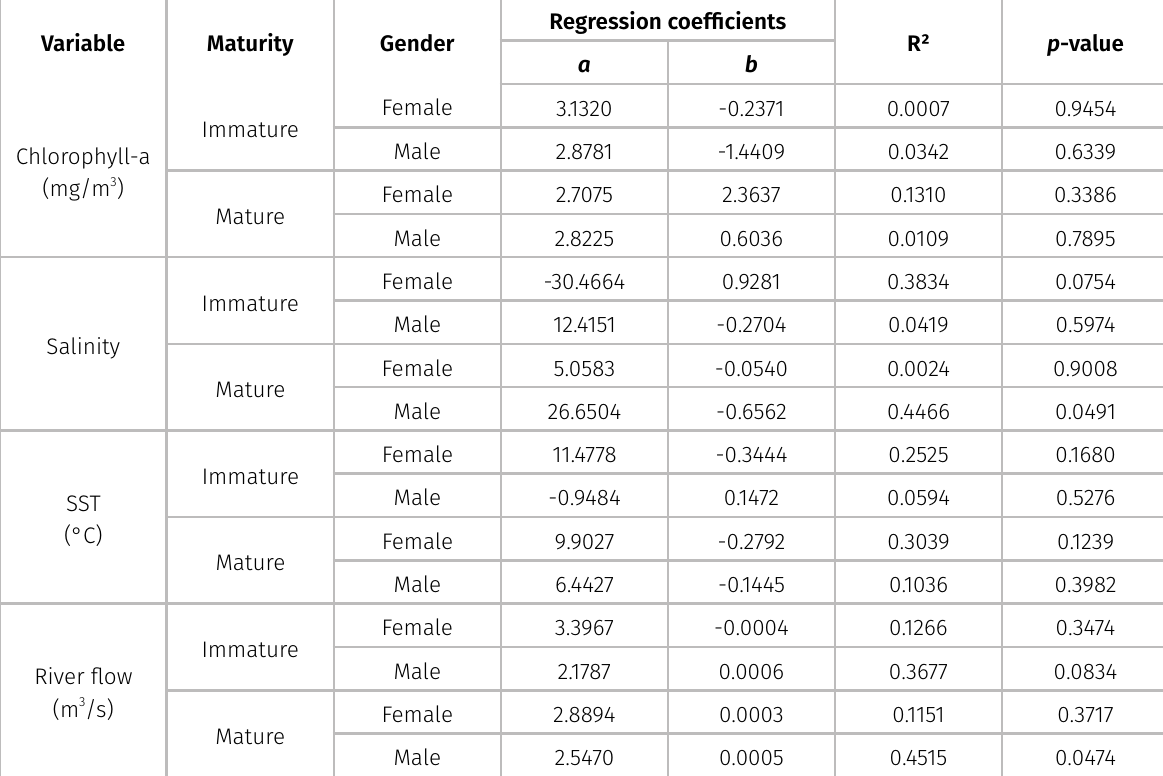
Table IV. Linear regressions between allometric coefficients of males and females from different maturity stages of Xiphopenaeus kroyeri from northern Rio de Janeiro State, southeast Brazil, and environmental variables (sea surface temperature - SST, salinity, chlorophyll-a, Paraíba do Sul River flow (or organic matter availability). The equations, determination coefficients (R²) and p -values are shown. Equation coefficients ( a and b ) refers a general linear